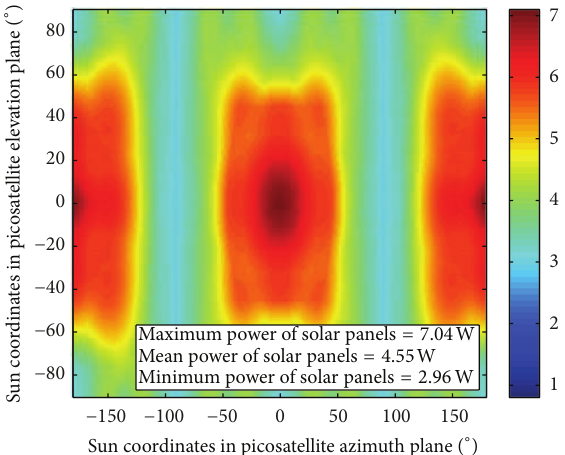
Figure 10: Power generation of gallium arsenide based solar panels placed on PilsenCUBE picosatellite including deployable panels—angle efficiency dependence is covered; 60 ∘ C operational temperature is